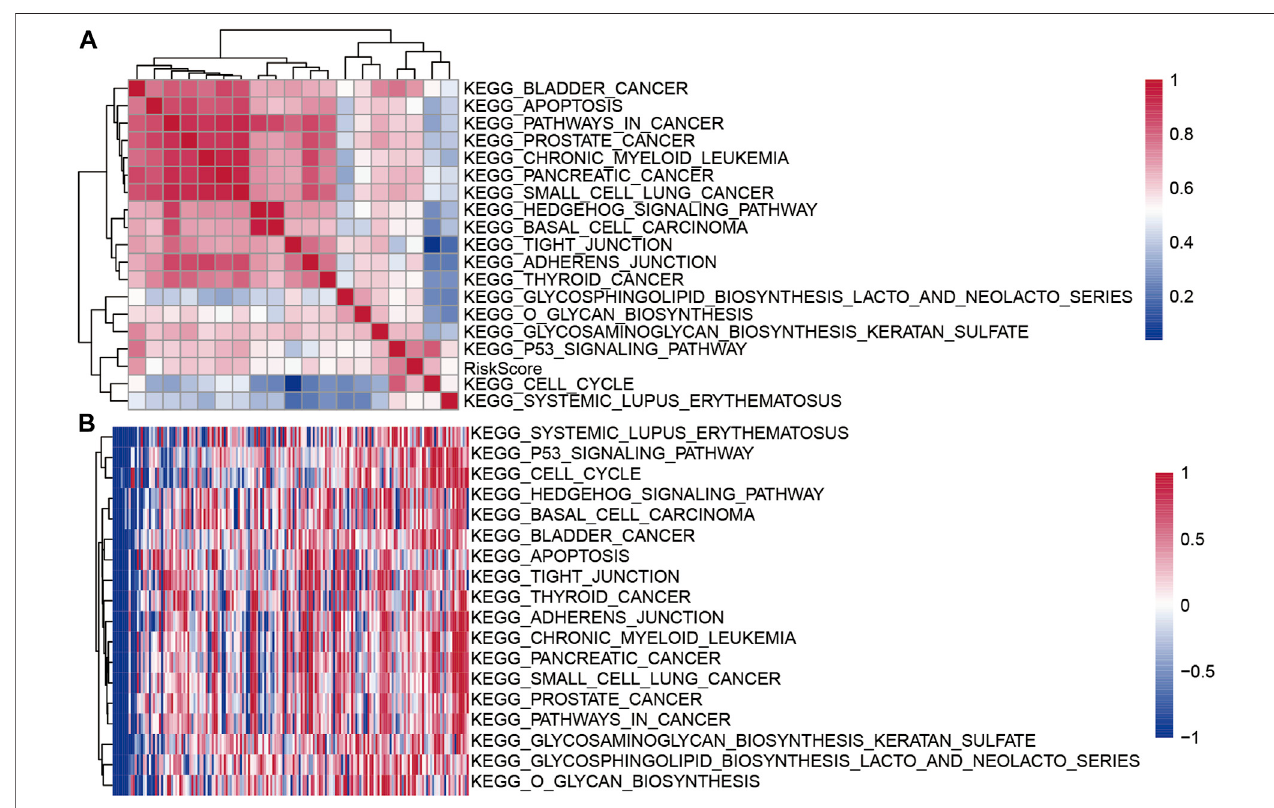
FIGURE9 |(A) Clustering correlation coef fi cients forKEGG pathwaysand RiskScores > 0.5; (B) ForKEGG pathwayswith riskscore correlations > 0.5, thechange intherelationshipofssGSEAscoreforeachsamplewiththeincreaseinriskscorewascalculated.Thehorizontalaxisrepresentsthesample,andtheriskscoreincreases from left to